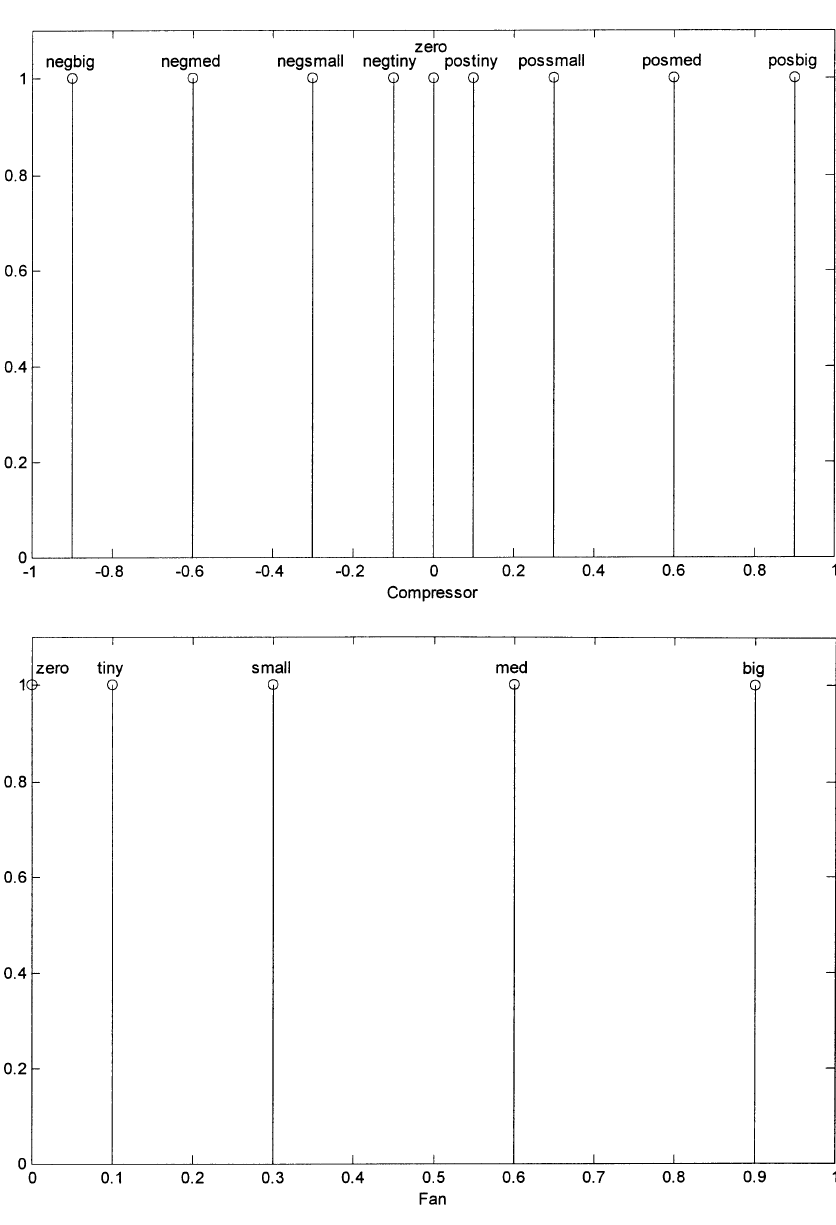
FIGURE 5 Output linguistic terms and corresponding singleton